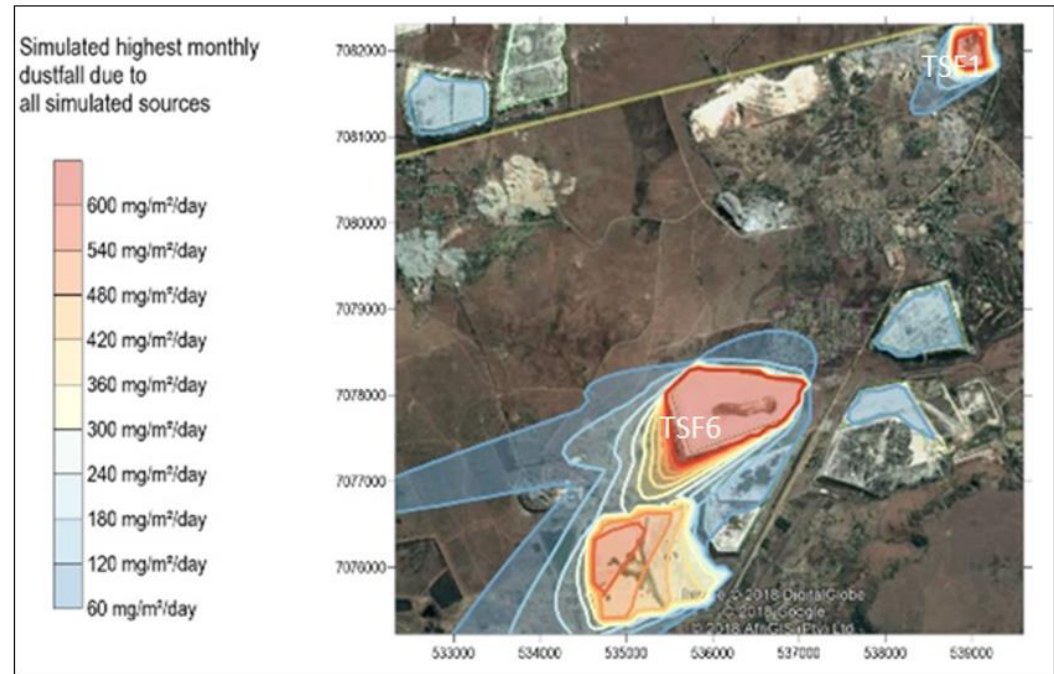
Figure 9. Simulated highest monthly dust fall due to all simulated sources.